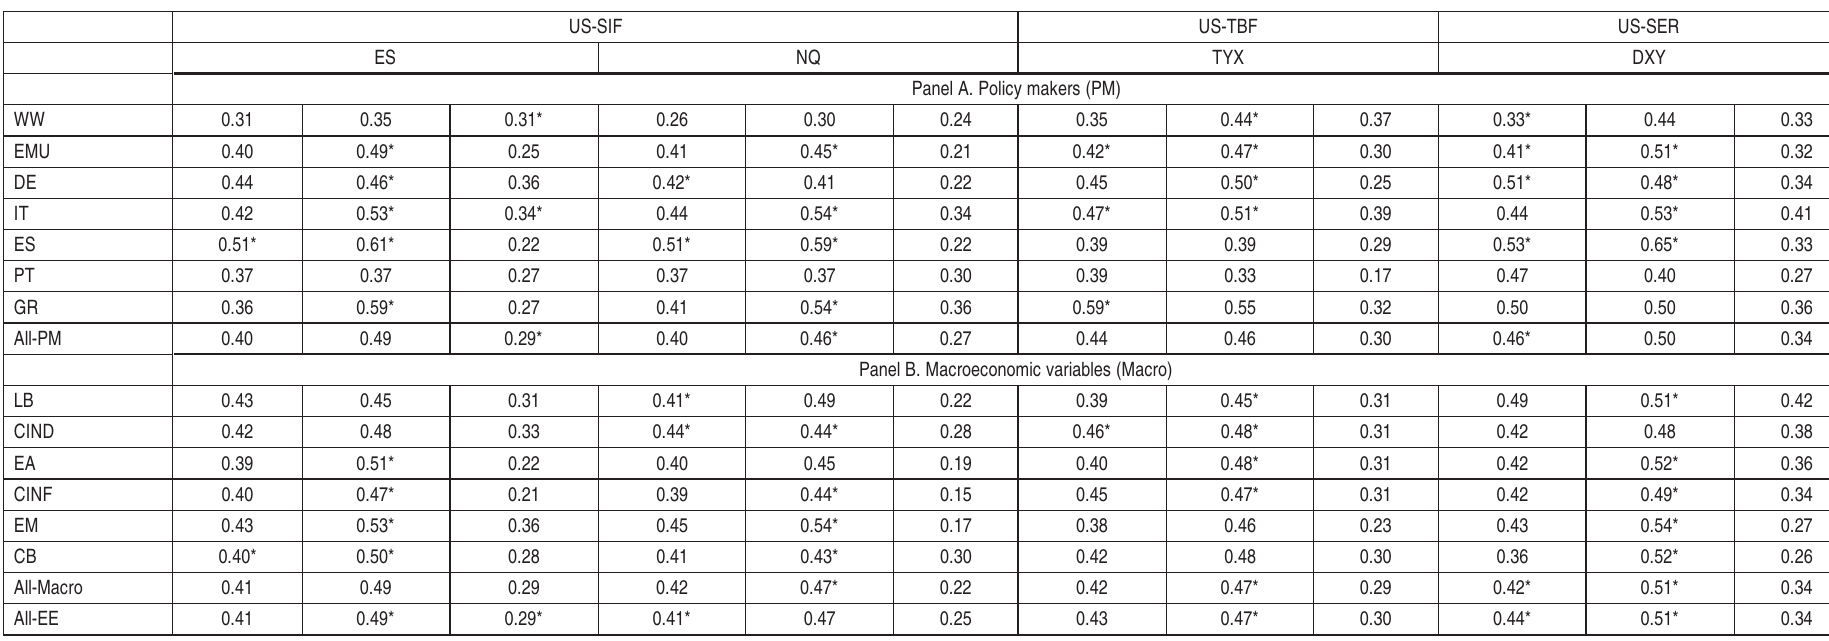
Table 8. Jump magnitude criterion - US stock index futures (US-SIF), US Treasury bond futures (US-TBF) and US spot exchange rates (US-SER) markets US-SIF US-TBF US-SER ES NQ TYX DXY Panel A. Policy makers (PM) WW